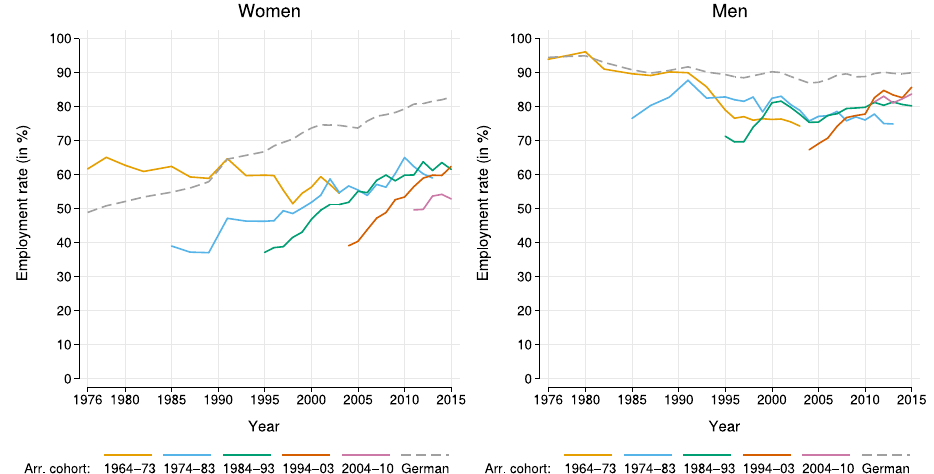
Figure 2 : Employment rates by period and arrival